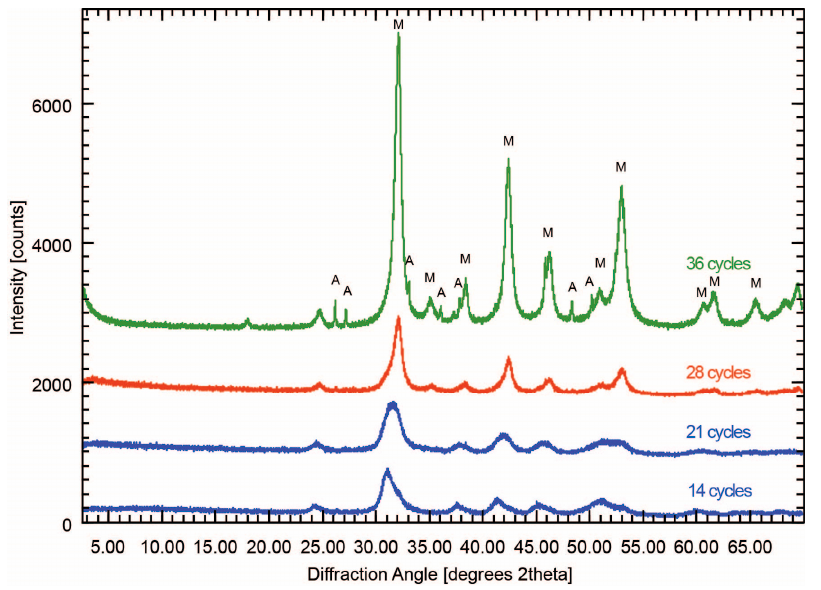
Figure 7. Powder X-ray diffractograms of reaction solids after 14, 21, 28 and 36 diel cycles (each indicated by a different colour) in the second series of pH cycling experiments, which contain zinc ions. The composition changes gradually from high magnesium calcite and huntite to magnesite (M) and minor aragonite (A).